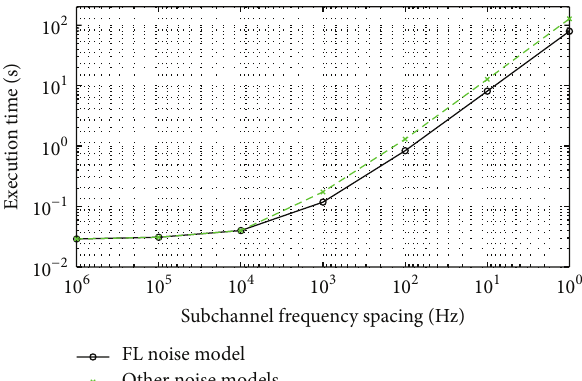
Figure 9: The execution time of the seven noise models in the 3–88 MHz frequency range for different flat-fading subchannel frequency